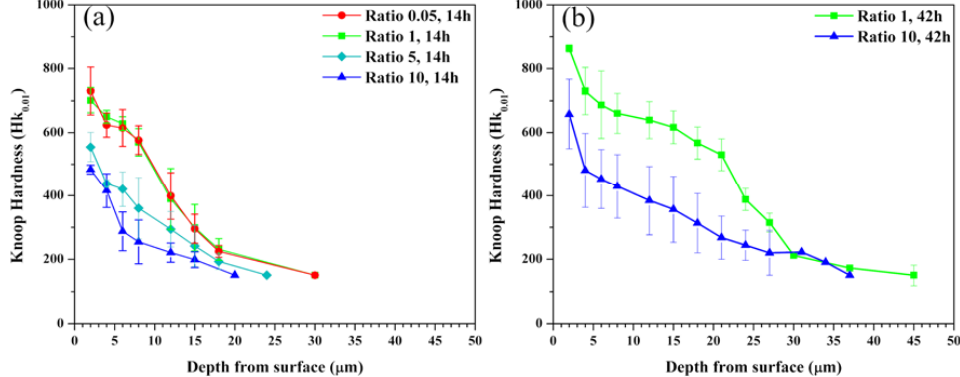
Figure 4. Hardness depth profile of ASS samples carburized for ( a ) 14 h and ( b ) 42 h.